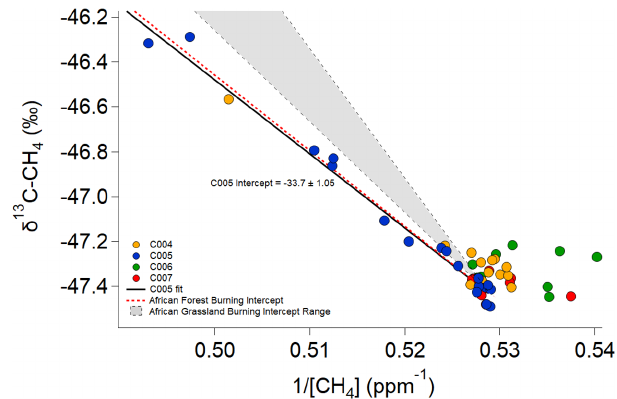
Figure 4. Keeling plot ( δ 13 C-CH 4 vs. inverse CH 4 mixing ratio) for all flights in the MOYA-I (Senegal) analyses. A linear fit of points from flight C005 (blue) is also displayed. Simulated fits of African forest (red dashed line) and grassland (grey shaded area) burning using the intercepts and intercept ranges reported by Chan- ton et al. (2000) are also